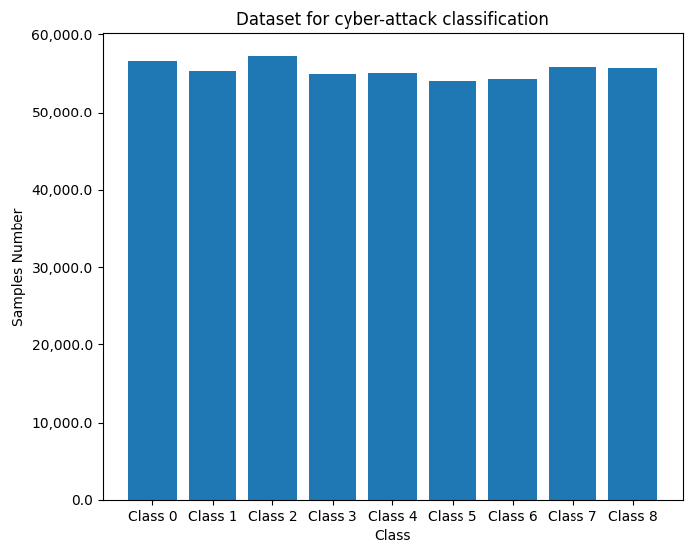
Figure 12. Dataset for cyber attack